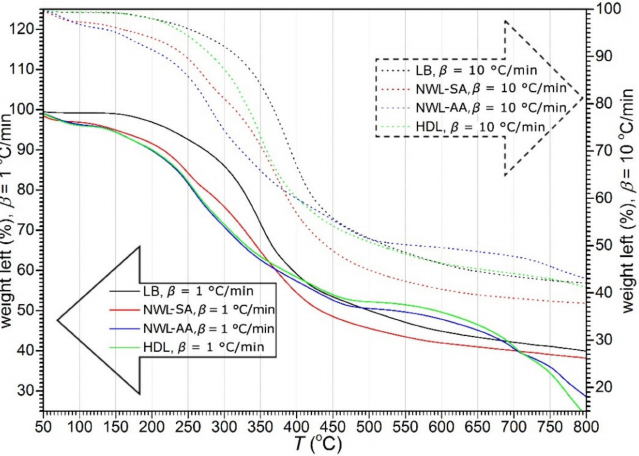
Figure 2. The derivative thermogravimetry ( DTG) curves of lignin samples at two heating rates. Solid lines (belonging to the left axis) represent weight loss during the heating rate β = 1 ◦ C / min and dashed lines (belonging to the right axis) represent weight loss during the heating rate β = 10 ◦ C /